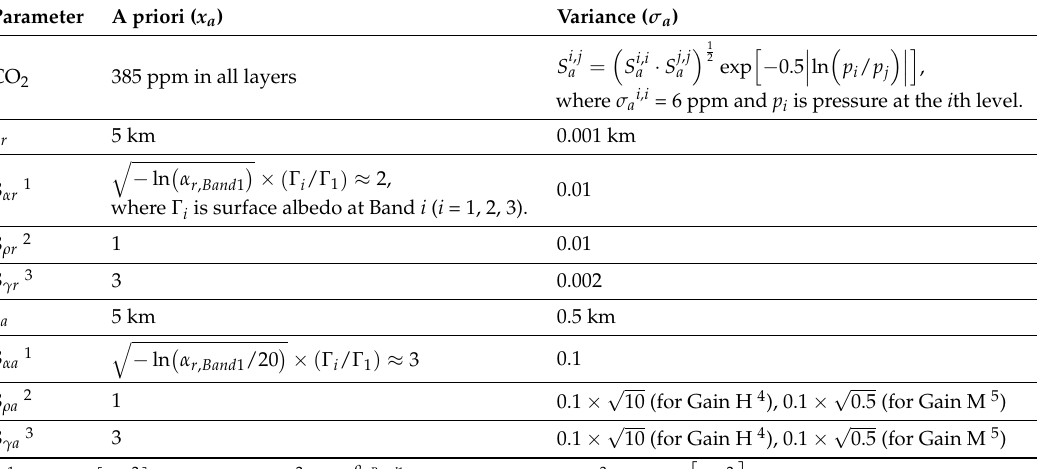
Table 2. A priori and variance of respective retrieval